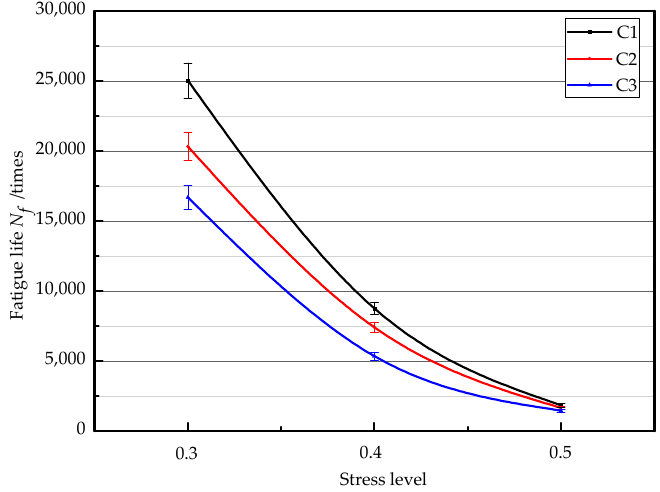
Figure 8. Fatigue life of different thickness structure combinations at 15 °C.